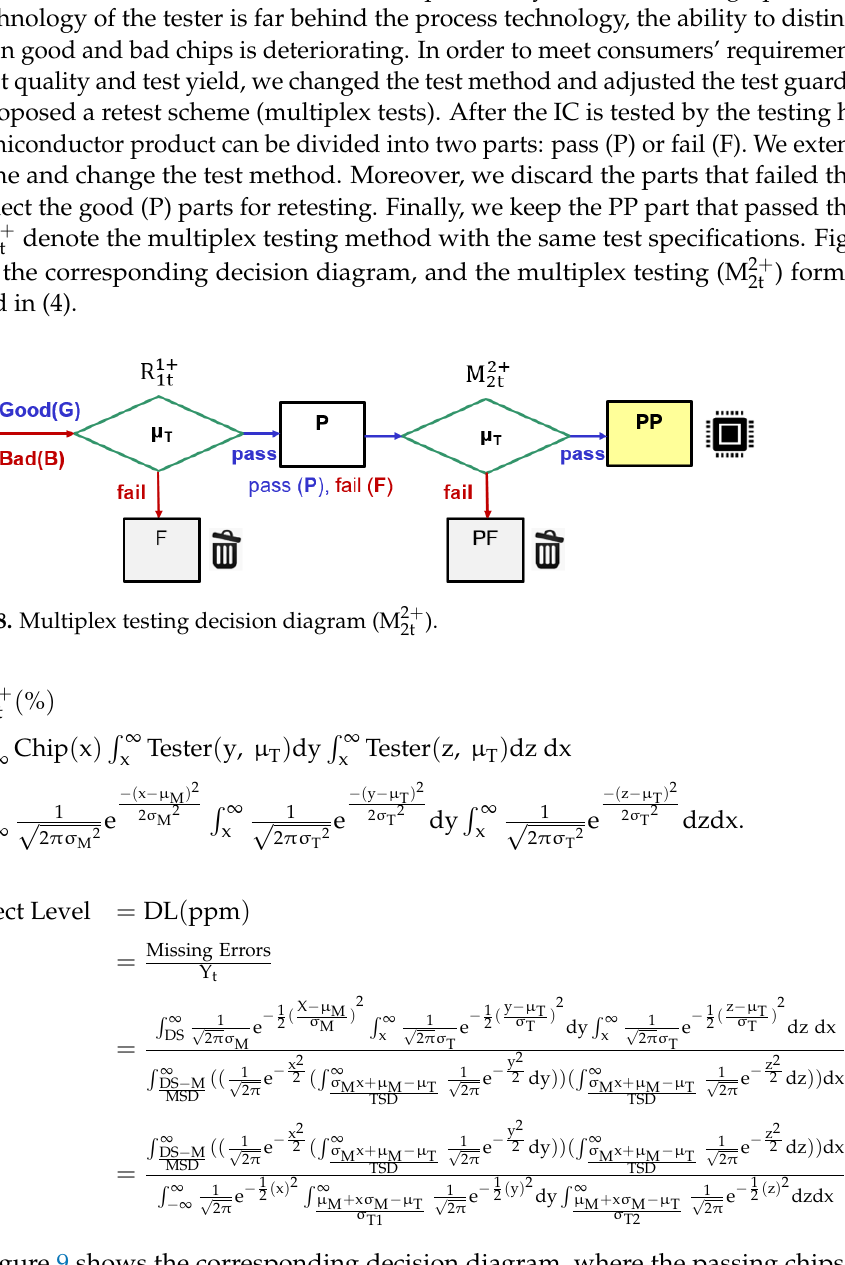
Figure 9. Test decision diagram for multiplex testing (M (cid:2924)(cid:2924)(cid:2878) ) .